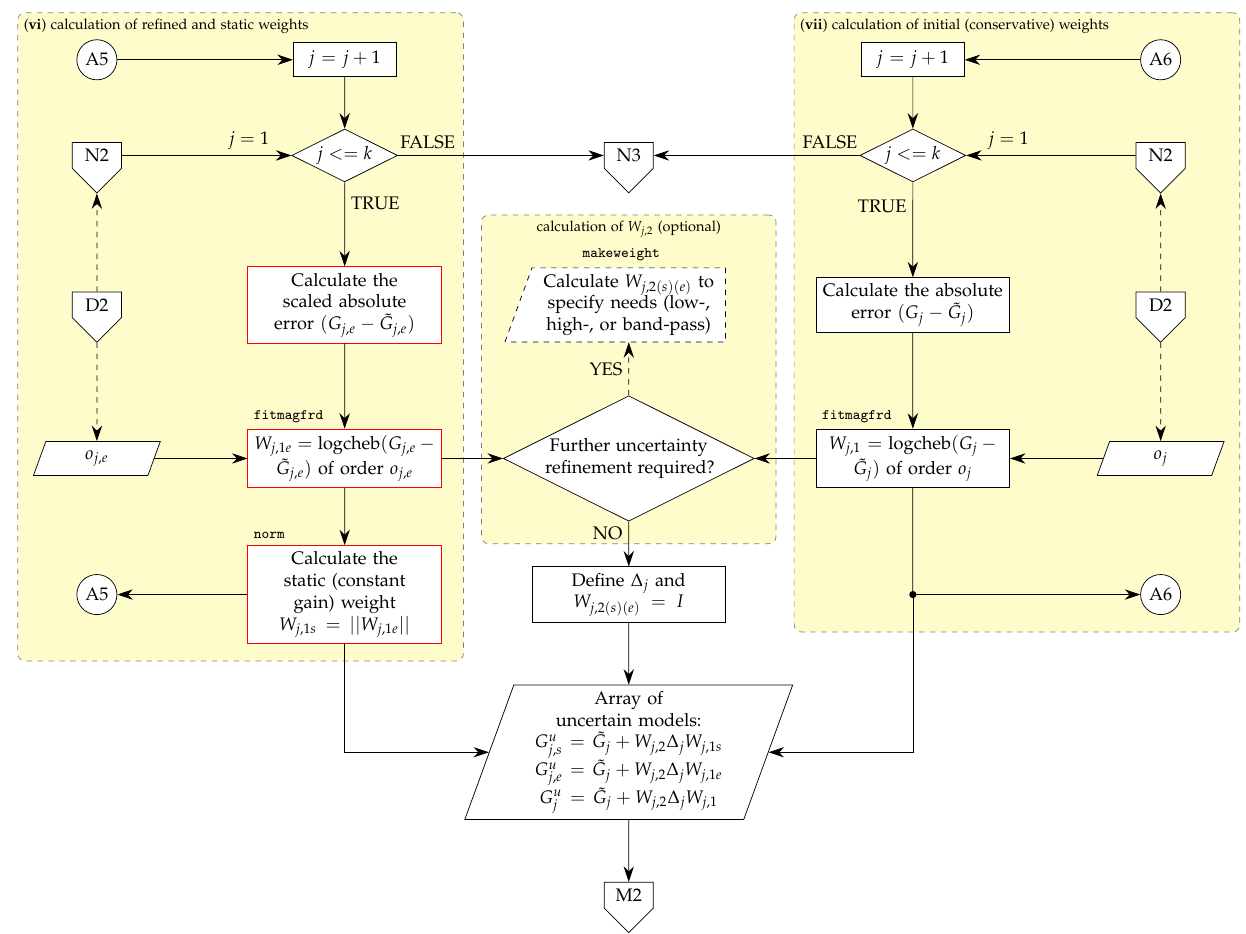
Figure 5. Uncertainty modelling and uncertainty refinement through the creation of weights W j ,1 and W j ,1 e , respectively. Calculating the absolute error and obtaining weights for each subsystem, without taking into account the (dissipative) surroundings of the subsystem yields conservative results (i.e., W j ,1 , a process denoted as (vii)). Calculating the absolute errors for each subsystem that is scaled by its surroundings and turning it into refined weights W j ,1 e , results in lower magnitude in frequency response in wide frequency range—hence less conservative uncertainty model was achieved. The scaled weights can often be further simplified by simply replacing it by its peak response—this offers a flexible and useful trade-of—reduce the order of the weights (i.e., no additional states